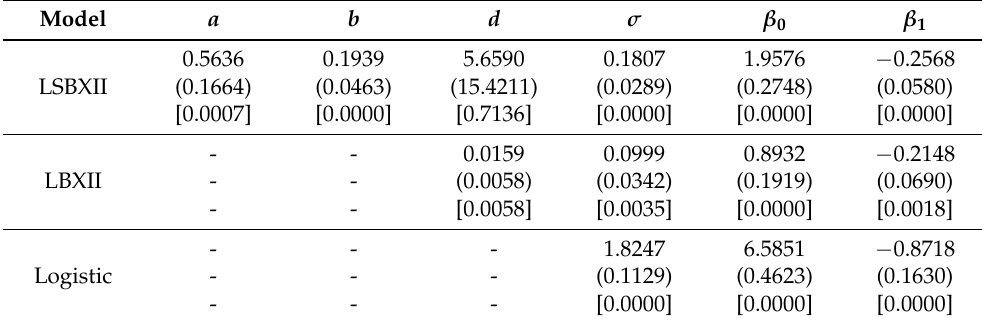
Table 6. MLEs, SEs, and p -values for three